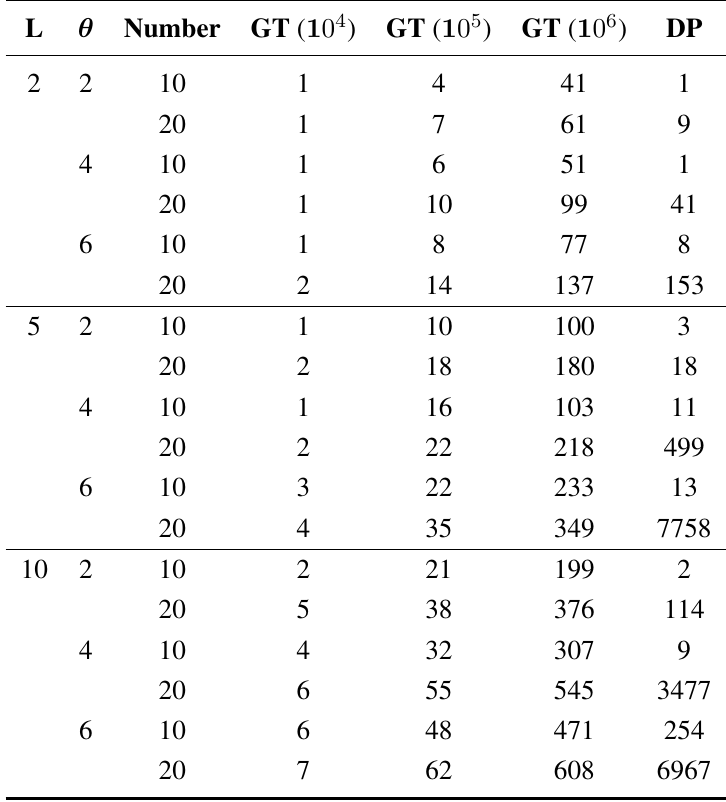
Table 3. Comparison of run times between maximum likelihood estimates of θ calculated with the dynamic programming (DP) method and the with Griffiths and Tavaré (GT) method for 2, 5, and 10 loci and 10 and 20 haploid individuals. The values stated are the run-times in seconds. All runs were started with different random number seeds.